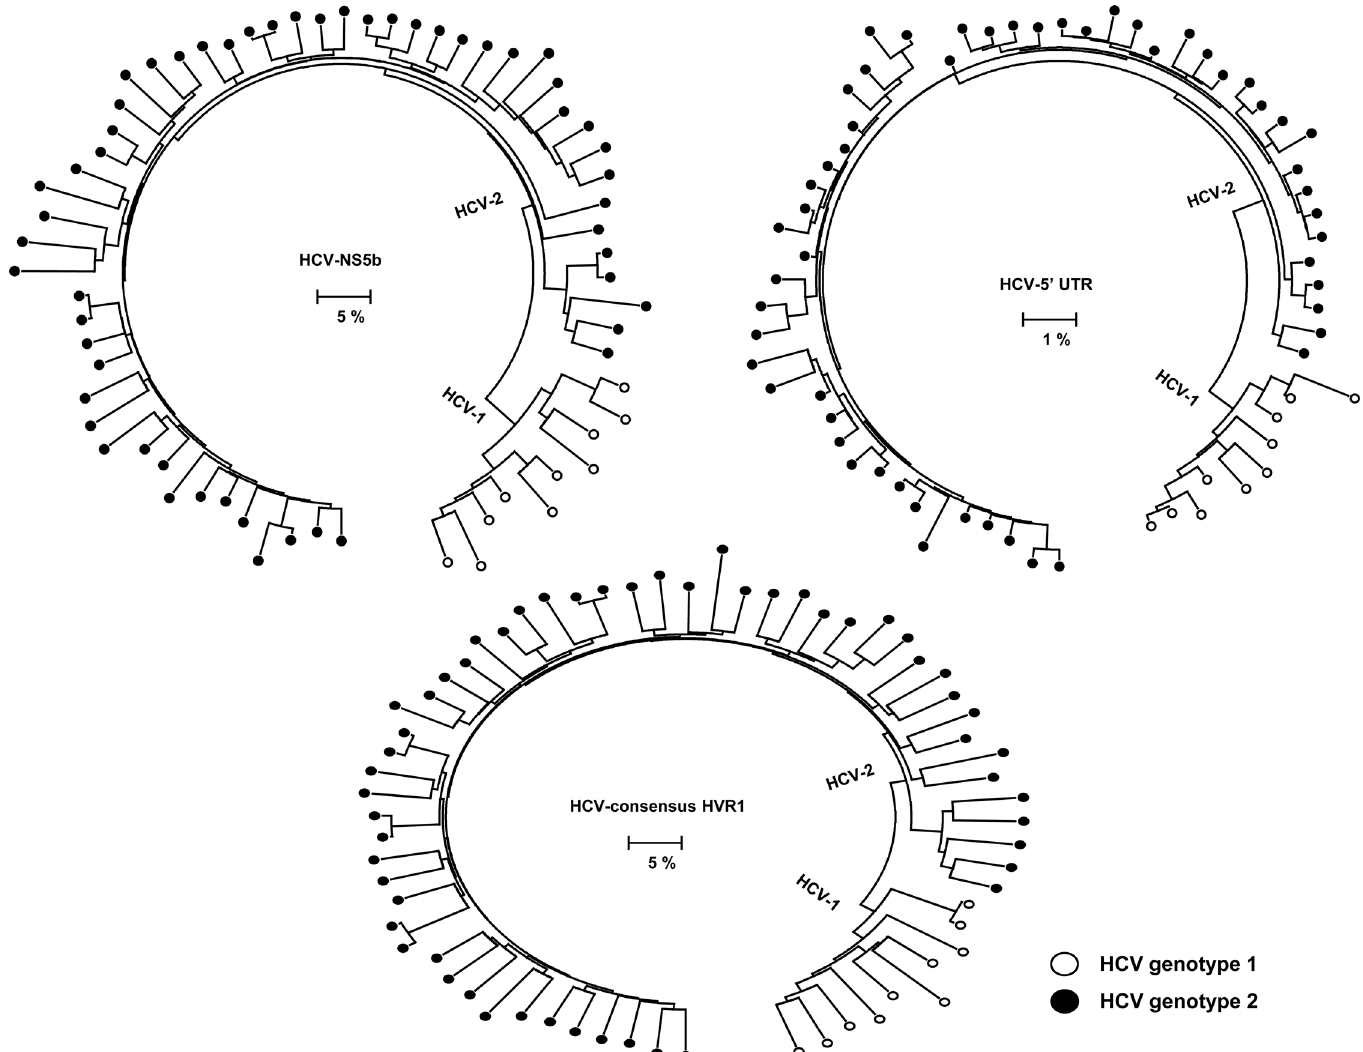
Fig 1. Maximum likelihood tree reconstructed with consensus NS5b, 5'UTR and consensus HVR1 gene sequences generated in this study. HCV-1 isolates are shown in black unfilled circles while HCV-2 are shown in black filled circles.